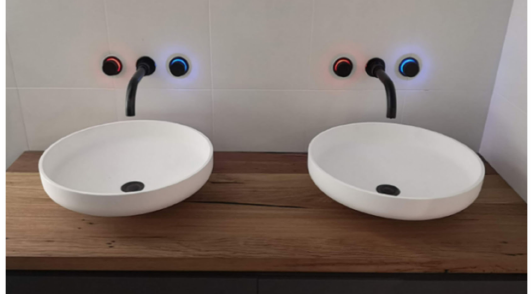
Figure 11. Innovative Desert Rose water tap. Reprinted from ref. [131].